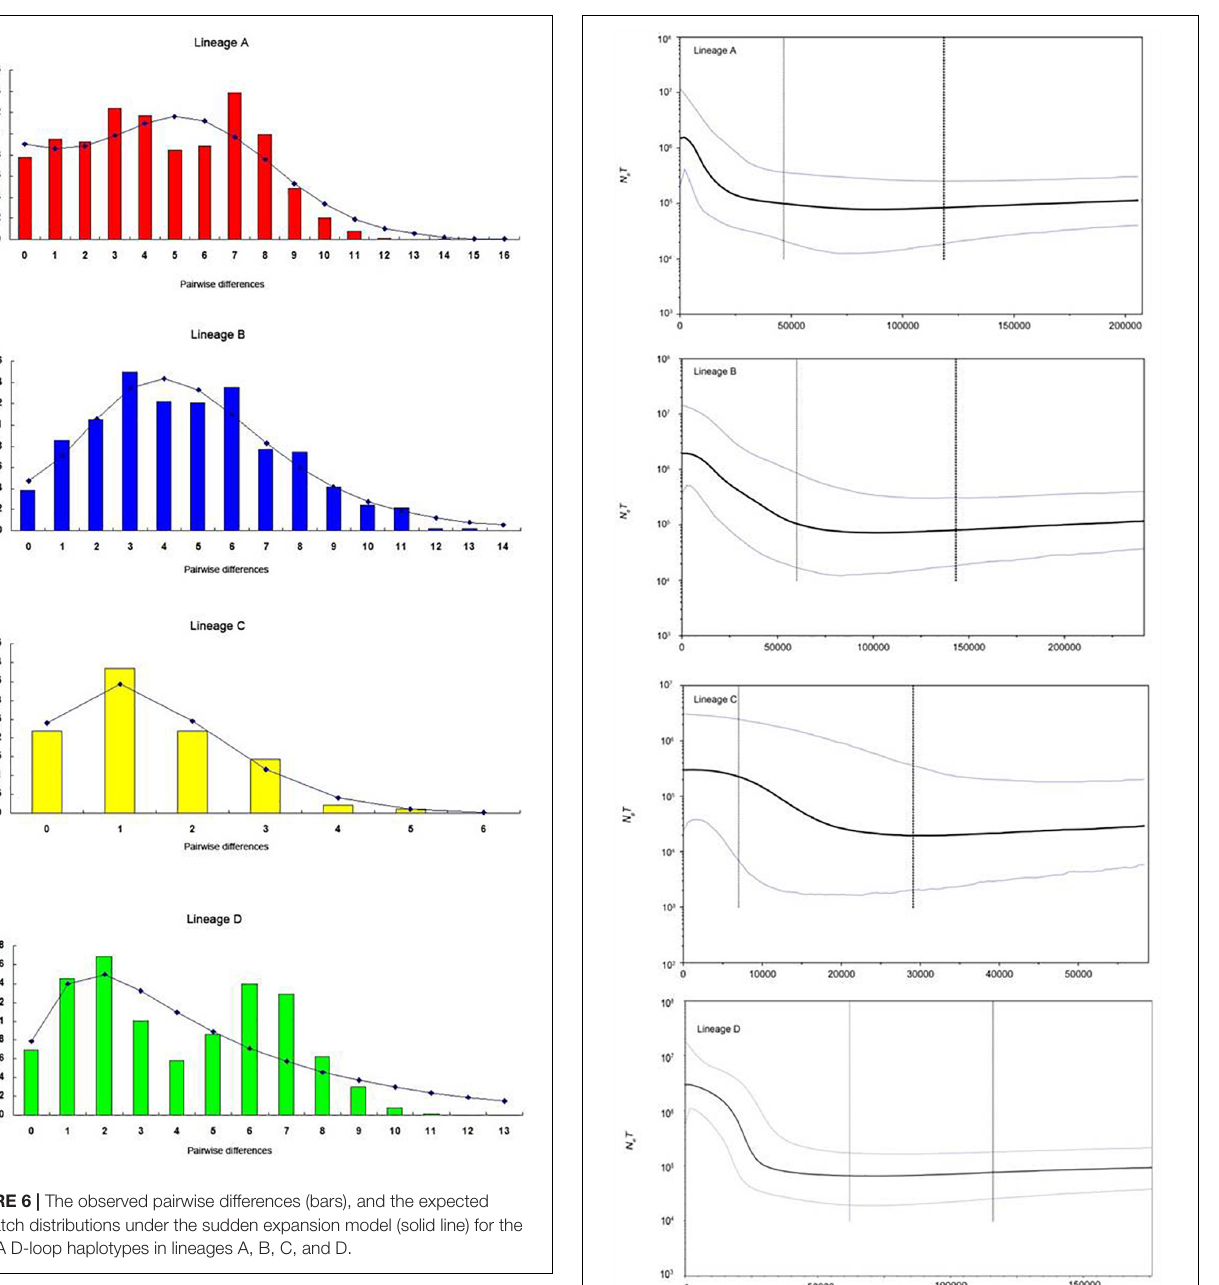
the East China Sea, the Huang River, and the Huai River) during the Pleistocene period should be responsible for the geographic distribution of the lineages in C. nasus